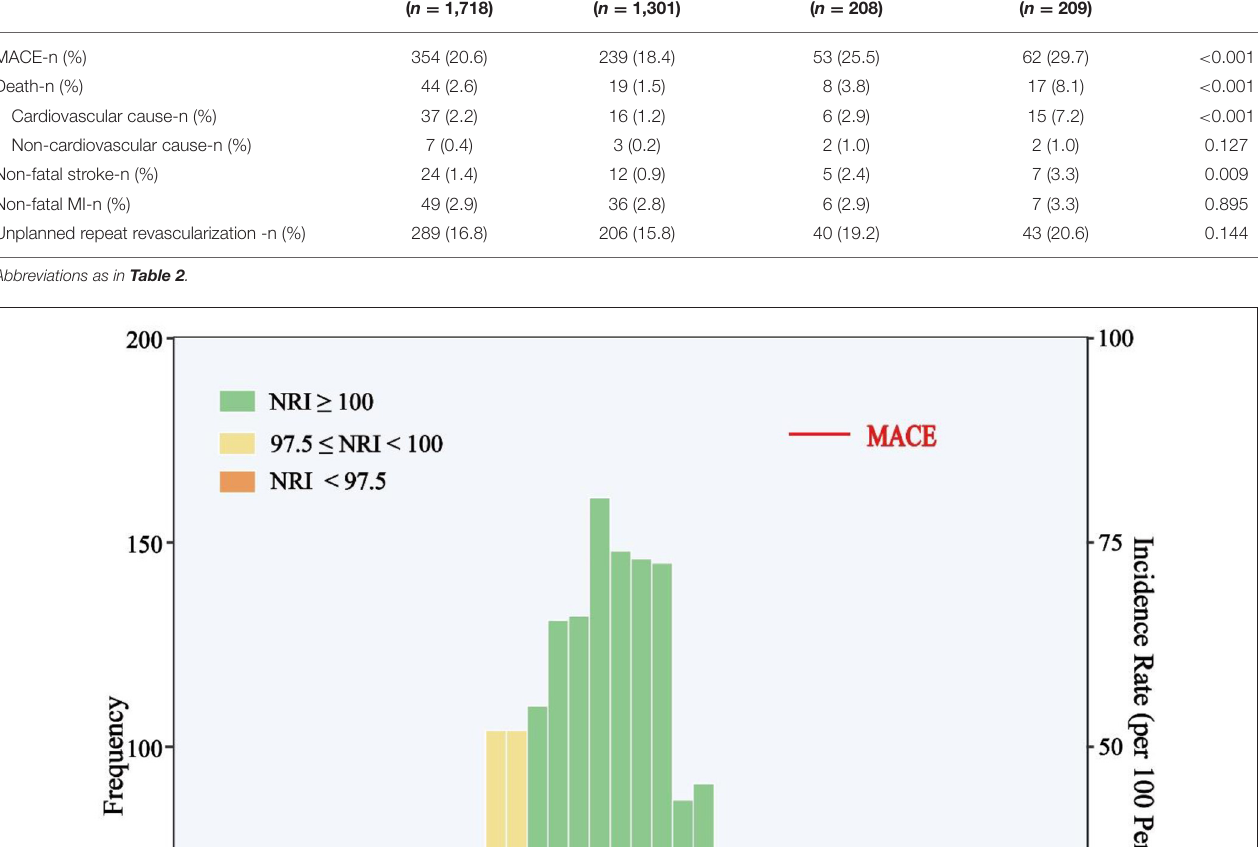
multiple confounding factors, compared with those with normal nutritional status, patients with malnutrition had significantly higher adjusted risk of MACE in both mild